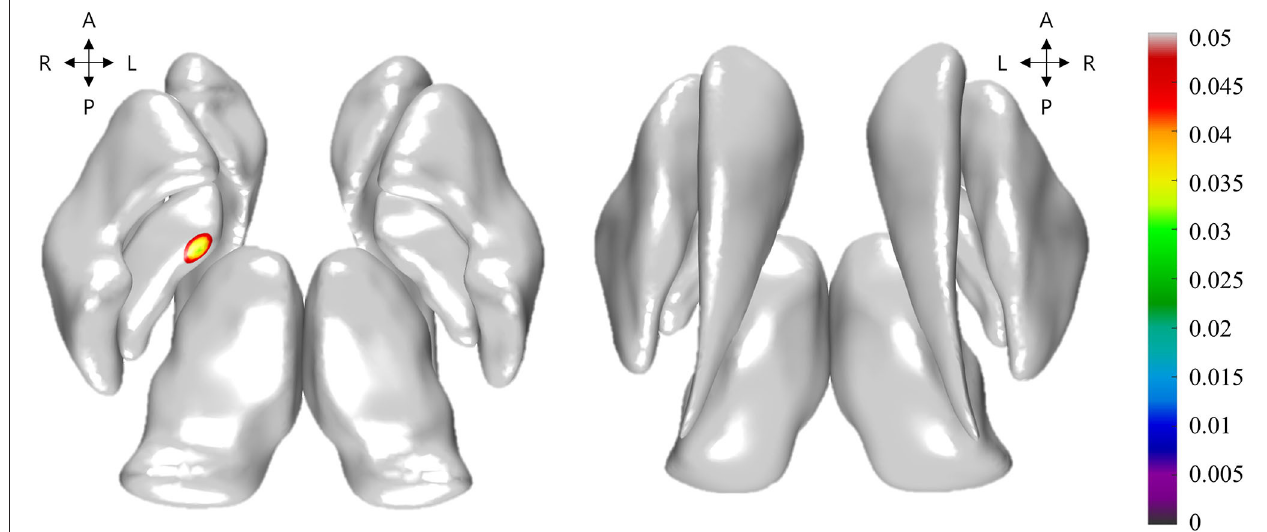
FIGURE 1 | Illustration of the group-wise differences of Jacobian between levodopa-induced dyskinesia (LID) group and non-LID group. Non-gray color regions denote the vertices with significantly different Jacobian. The color bar shows the corrected p -values for the statistical test. The left and right subfigures denoted the top axial view and bottom axial view,